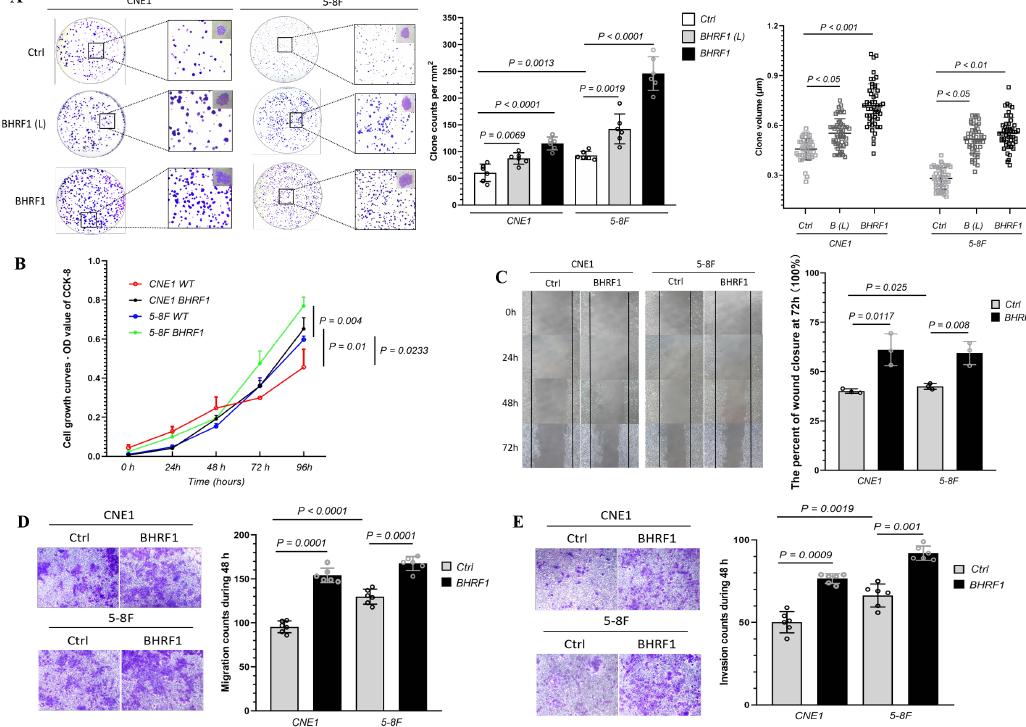
Figure 3. The high expression of BHRF1 enhanced tumorigenesis in NPC cells. ( A ), An equal number of cells (four replicates for each line) were suspended in DMEM medium with 10% FBS and seeded on 60 mm dish. The colonies were analyzed after 3 weeks and representative pictures of one of the three experiments were shown. The colonies 0.1 mm were scored with alpha imager colony-counting software. ( B ), Cellular viability after 0 h, 24 h, 48 h, 72 h, 96 h of growth in DMEM media was quantitated using Vi-Cell cell viability analyzer based on the trypan blue exclusion method. ( C ), Images of cell movement were captured at 0, 24, 48, 72 h and used to calculate the rate of wound closure by ImageJ. ( D ), Cell migration was analyzed using trans-well assay (four wells / line) and cells that migrated to the lower surface were stained and imaged. E, Cell invasion was analyzed by the matrigel solution and trans-well. A total of three independent fields per well were selected for counting invasion cells using NIS-e lement software. Representative images ( n = 3) are shown and quantitation represents mean ± SE of three independent